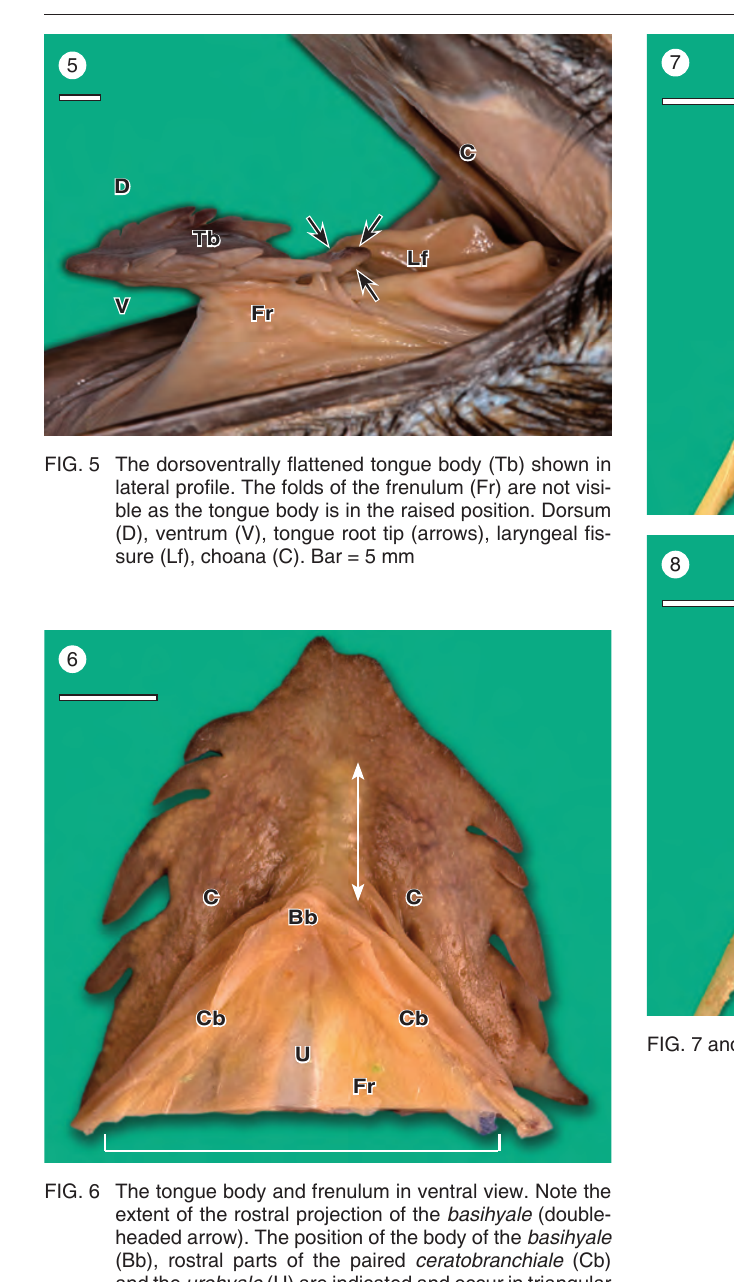
branchiale and the raised margins of the laryngeal fissure (Fig. 4). The surface of the root displays the same doughnut­shaped structures seen on the tongue body, particularly in the midline. A shallow retrolingual recess exists between the ventral as­ pect of the caudal lingual papillae and the tongue root.